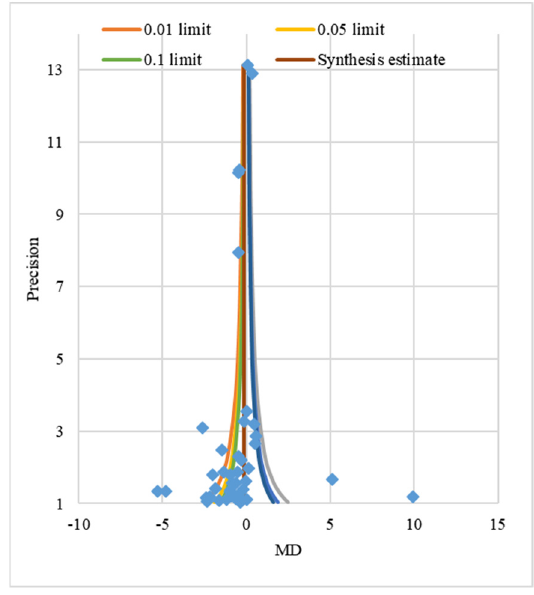
Figure 3. Publication bias analysis.